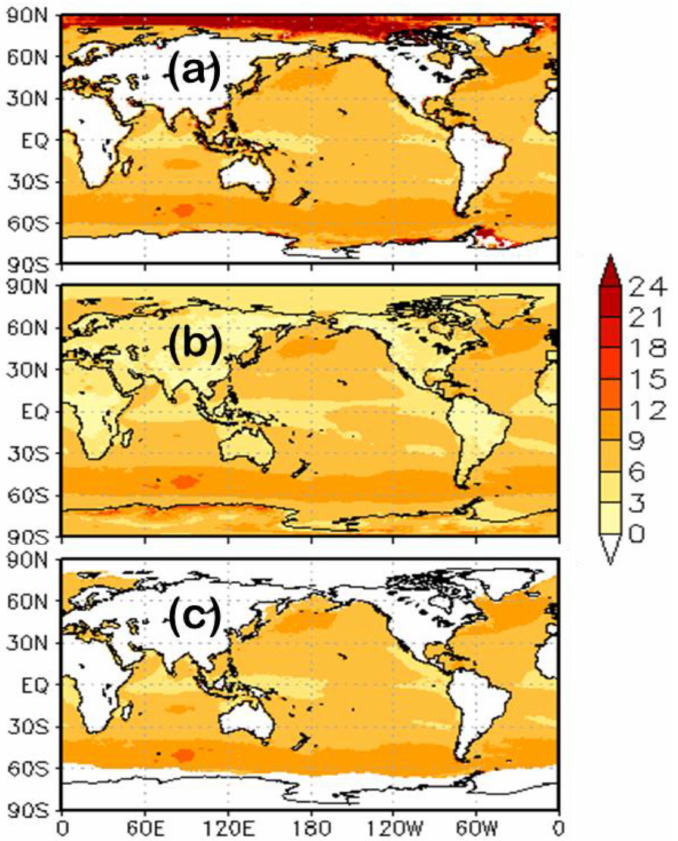
Figure 6. Mean wind field Jan–Dec 2018 from ( a ) SCATSAT-1 ( b ) NCMRWF and ( c ) Particle filter- based